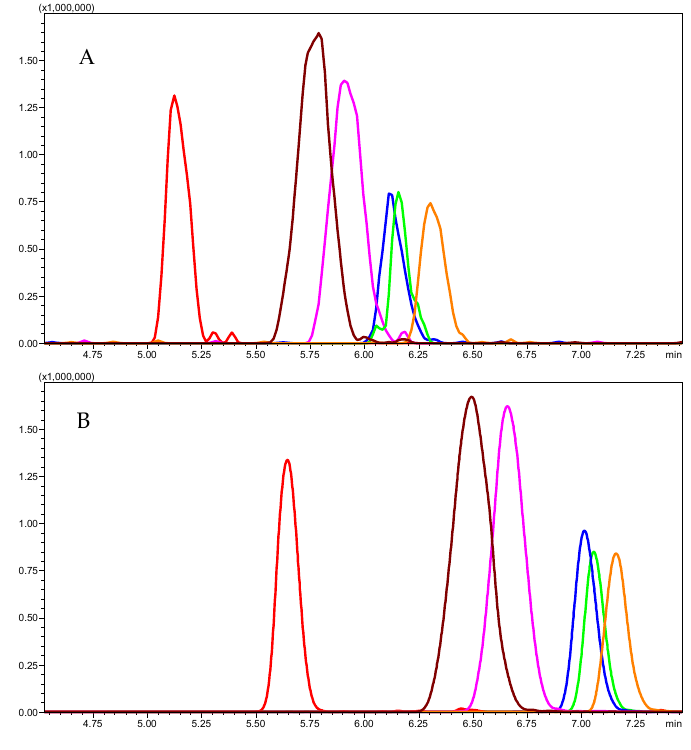
Figure 1 . LC-MS chromatograms (extracted ion currents (XIC)) for peptides 1 – 6 . Panel ( A ): Aeris Peptide XB-C 18 column. Panel ( B ): Kinetex Biphenyl column. Gradient: 5–80% acetonitrile in water in 10 min., both solvents contained 0.1% HCOOH.